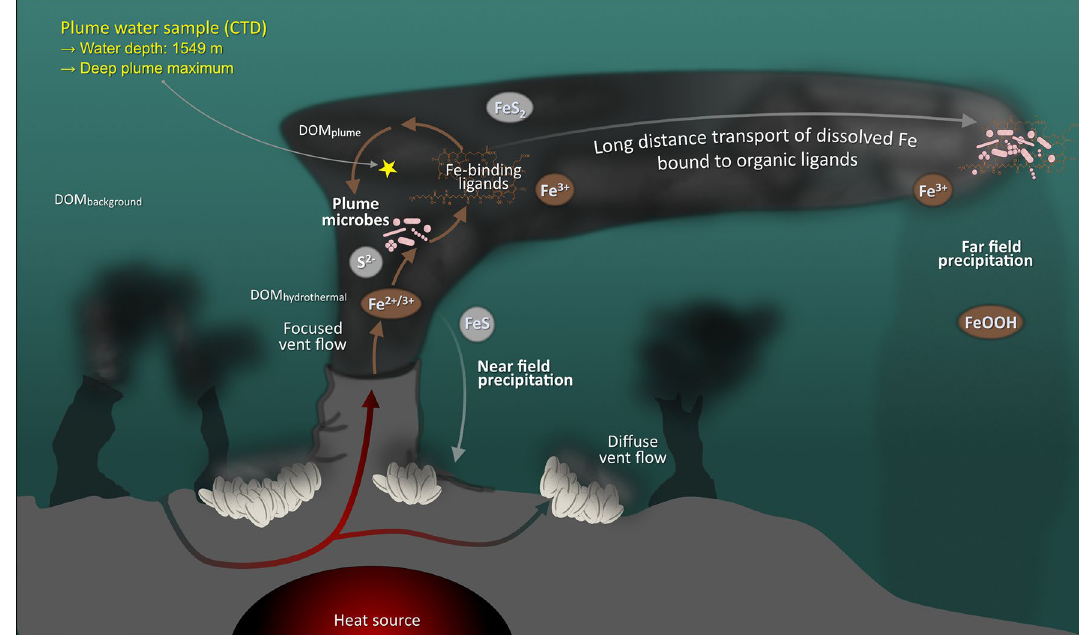
plume. Within the vent and plume, endemic microbes interact with dissolved organics (DOM) and potentially produce Fe-binding ligands. These interactions are crucial for the potential of Fe being exported away from the vent source. The bulk plume water sample (yellow star) used to set up the incubated dilutions (50 mL plume sample + 450 mL artificial seawater medium + individual Fe amendment) was collected using a rosette